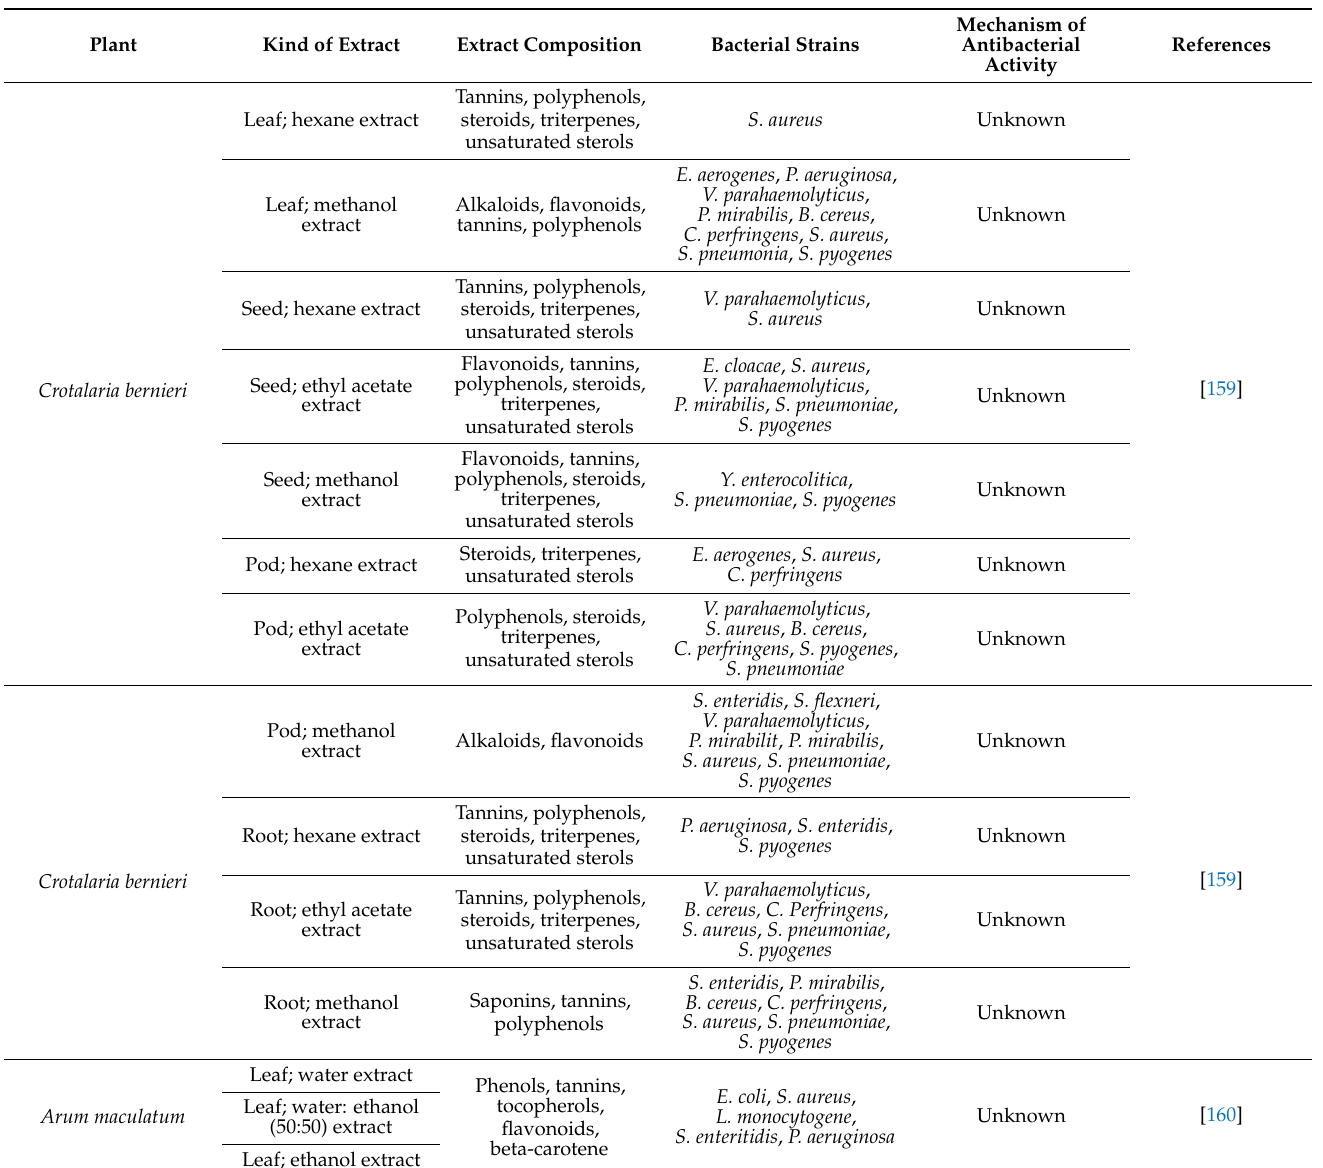
Table 4. Plant extracts with antibacterial